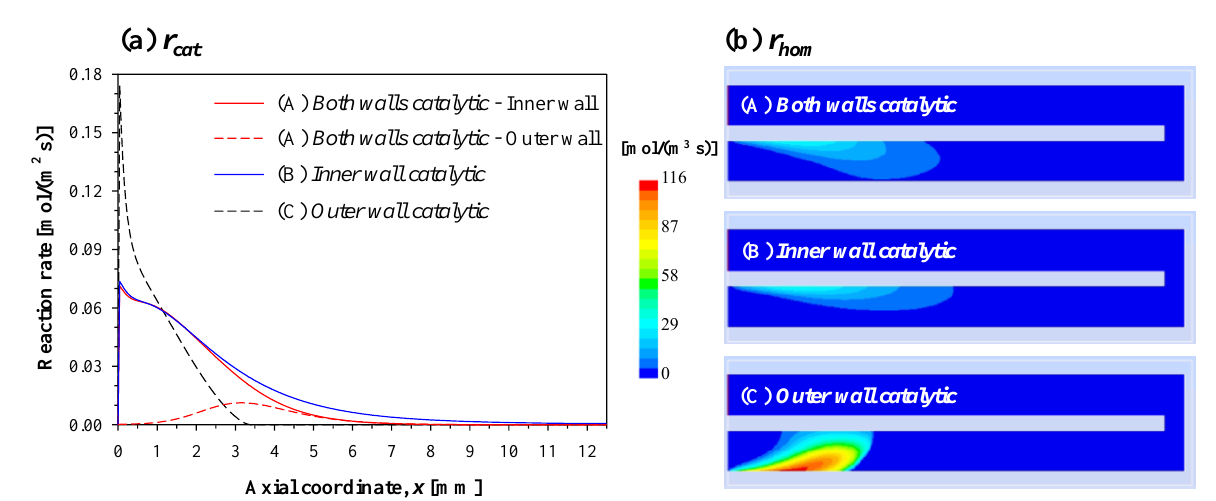
Figure 3. ( a ) Axial profiles of catalytic reaction rate and ( b ) contours of homogeneous reaction rate for the three reactor configurations of Figure 1 with different catalyst placement. Low thermal conductivity (3 W/(m K)) and V in = 0.5 m/s. In ( a ), only the inlet channel is shown, whereas the computational domain in ( b ) is scaled along the transverse direction by a factor of 2.